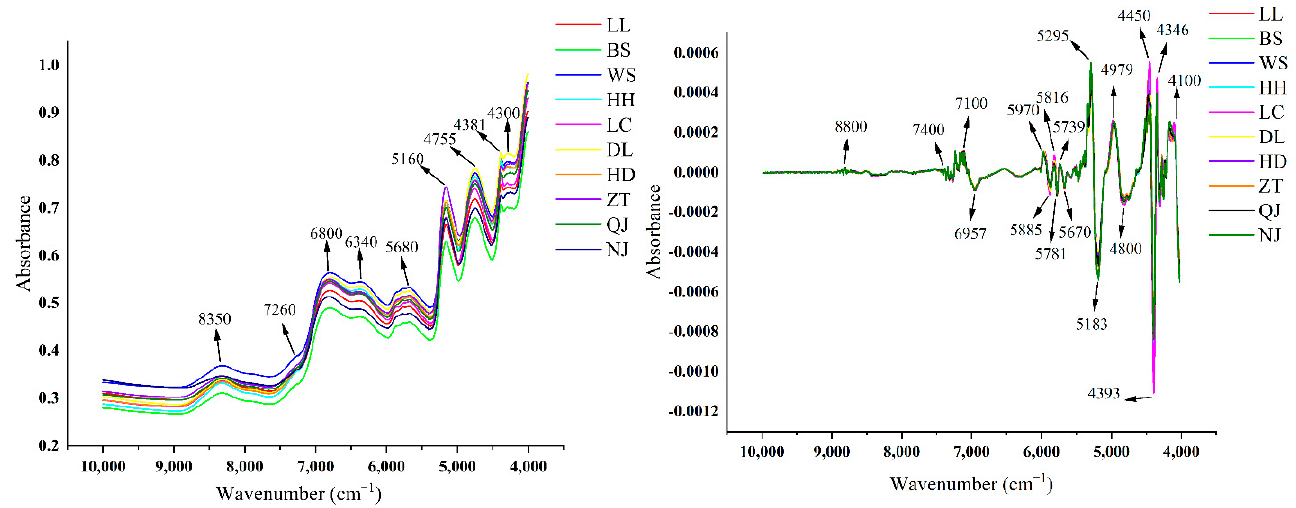
Figure 3. Average FT-NIR spectra, raw averaged FT-NIR spectra ( A ), MSC and SD preprocessing ( B ).